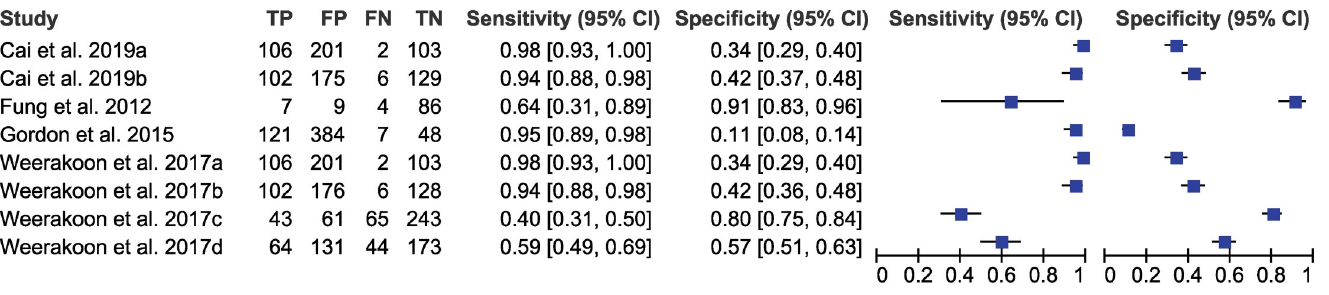
Fig 4. Forest plot of sensitivity/specificity of PCR ( S . japonicum with stool examination as a reference standard). Note: a-Fecal ddPCR; b-Serum ddPCR; c-Urine ddPCR; d-Saliva ddPCR.